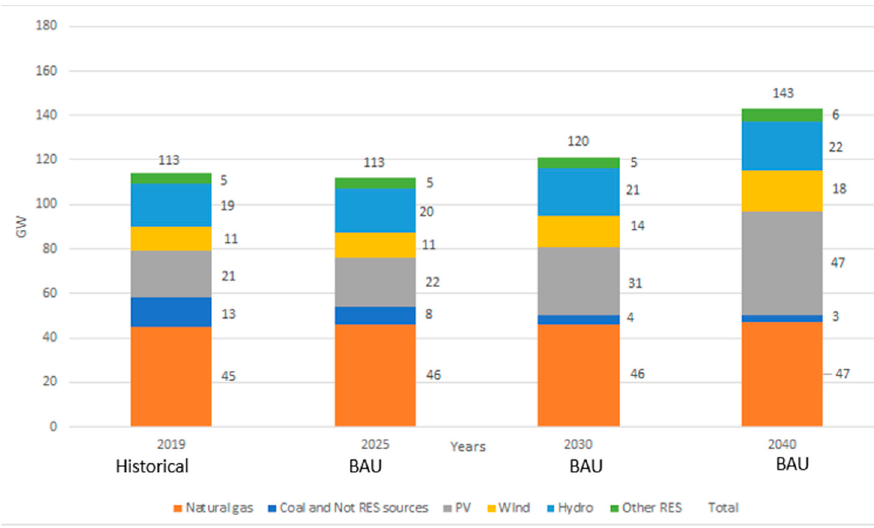
Figure 8. Historical and forecast of the Italian installed capacity per fonts by BAU scenario.